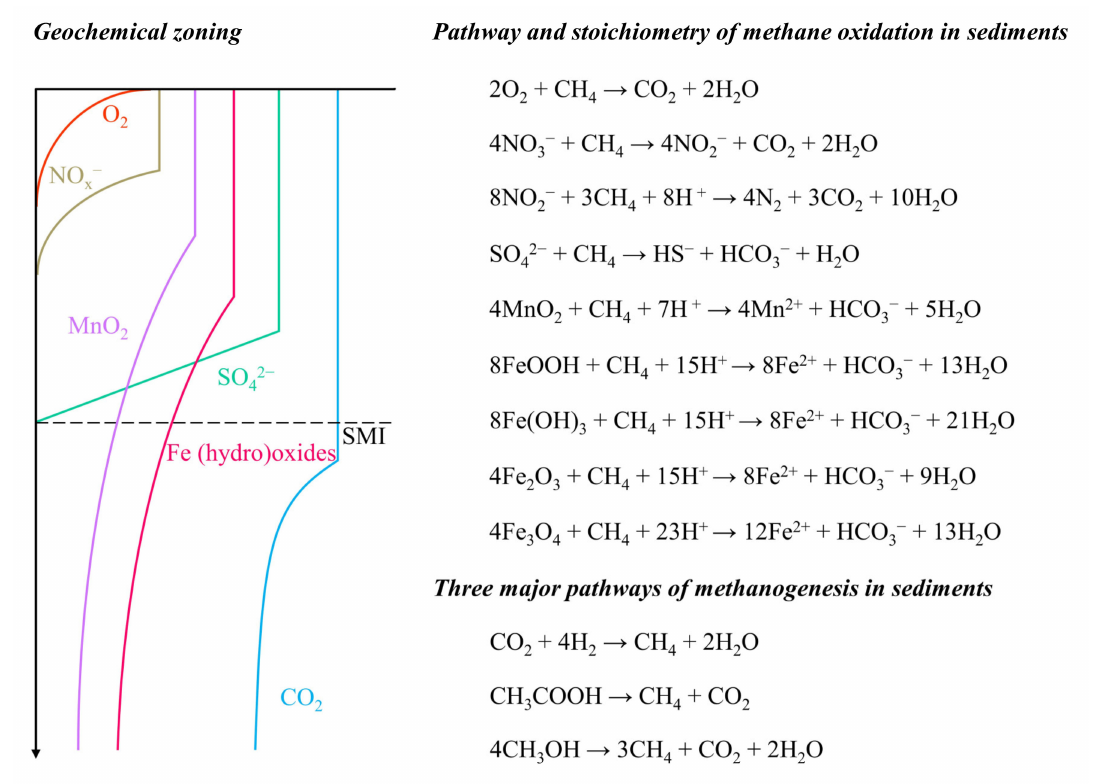
Figure 1. Pathways of CH 4 oxidation and three major pathways of methanogenesis (hydrogenotrophic, acetoclastic, and methylotrophic) in sediments. Among the materials involved, O 2 , NO x − (NO 3 − , NO 2 − ), SO 42 − , and CO 2 are dissolved in pore water, while MnO 2 and Fe (hydro)oxides in a solid state mixed with sediments. SMI: sulfate-methane